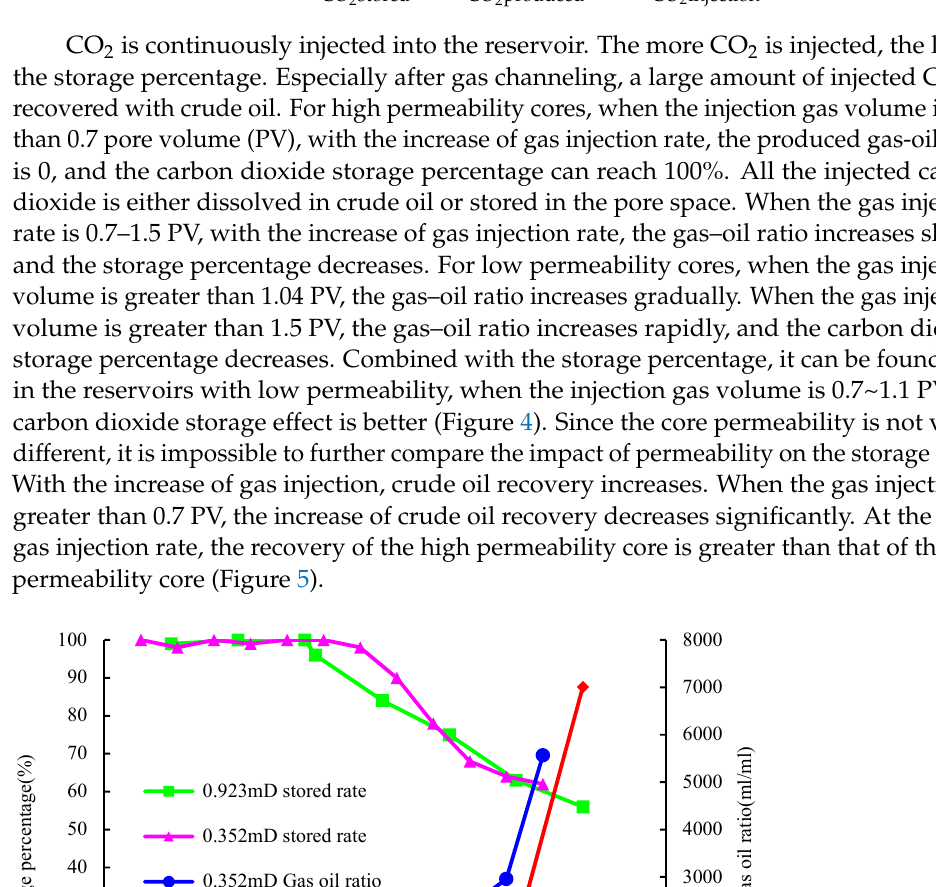
Figure 4. Relationship between injection volume and storage percentage at different rock permeability.